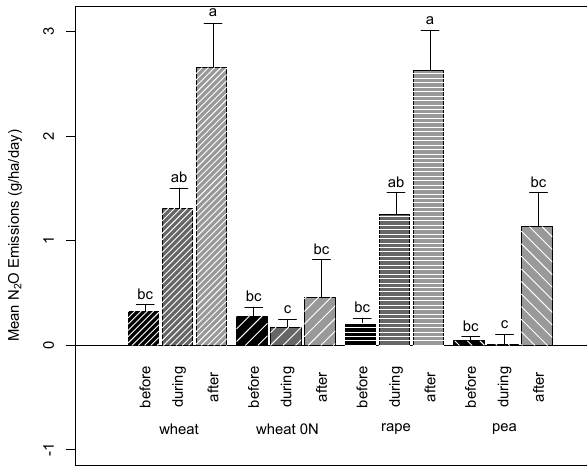
Fig. 4. Mean N 2 O emissions (gN-N 2 Oha − 1 day − 1 ) during autumn Figure 4: Mean N 2 O emissions ( g N-­‐N 2 O.ha -­‐1 .day -­‐1 ) during autumn as a function of the preceding crop (W= Wheat, R= Rape, P= Pea, W0N= unfertilized wheat) and year. Error as a function of the preceding crop (W=Wheat, R=Rape, P=Pea, bars= standard error of the mean. W0N=unfertilized wheat) and year. Error bars=standard error of the